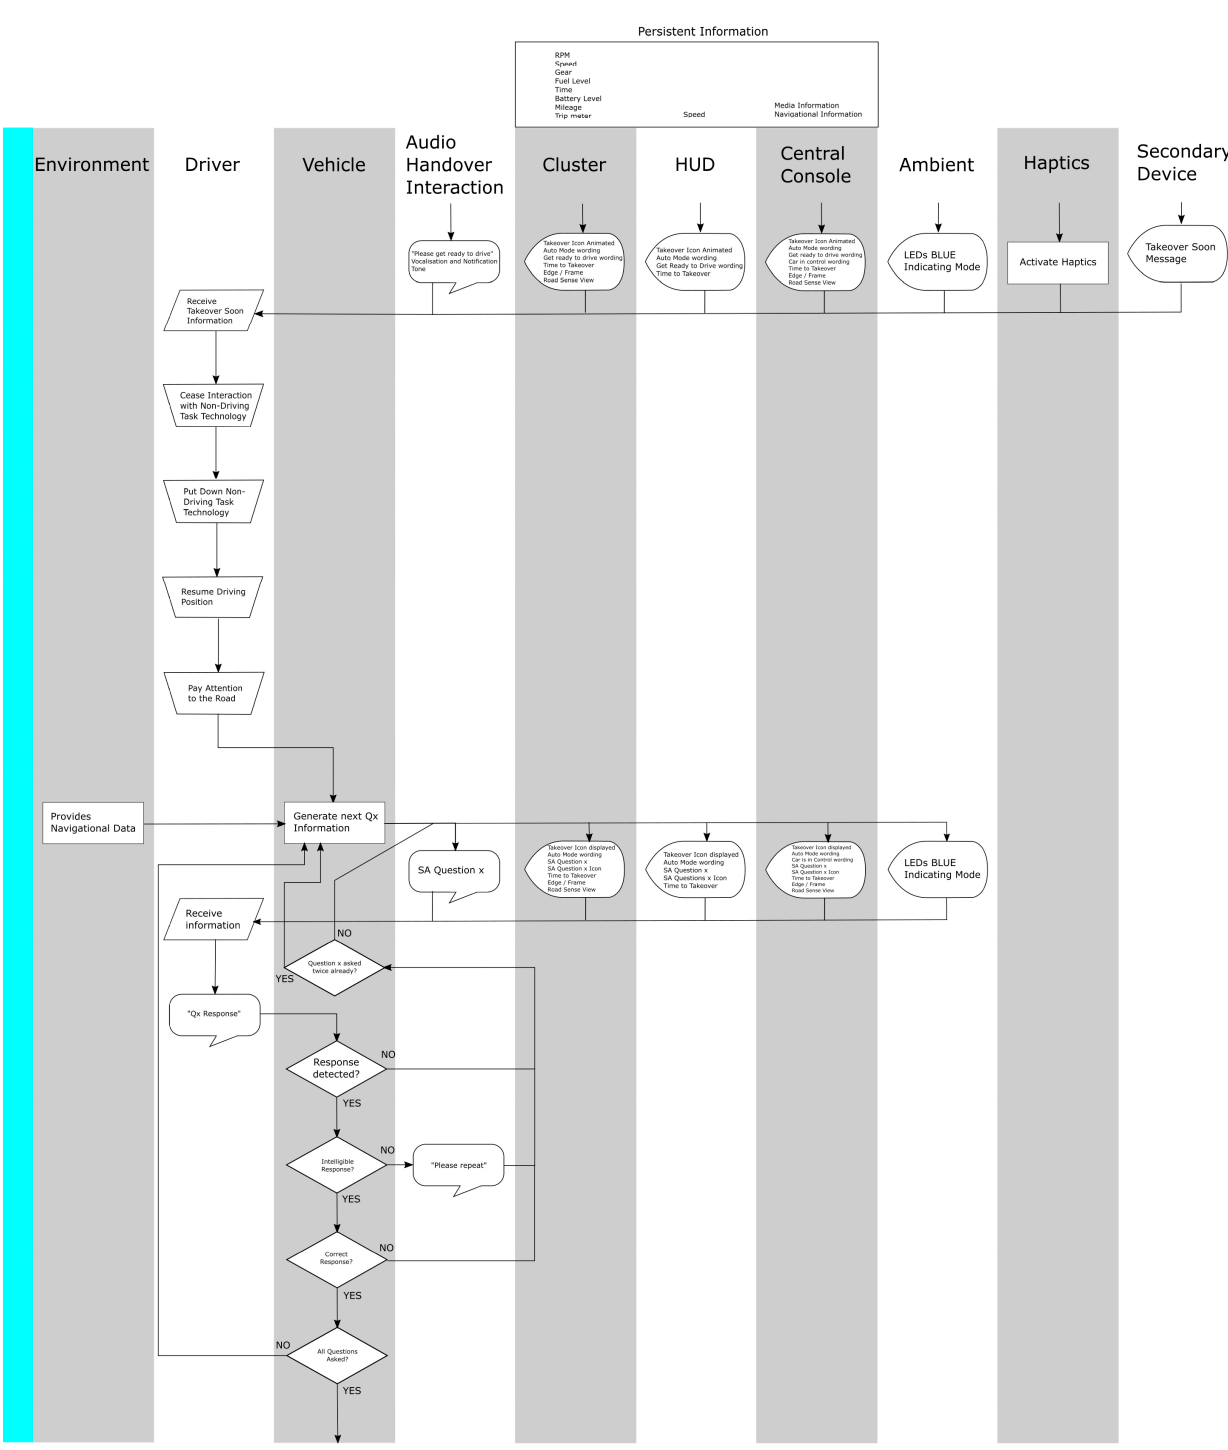
Figure 3. Driver resumes driving position and engages in handover